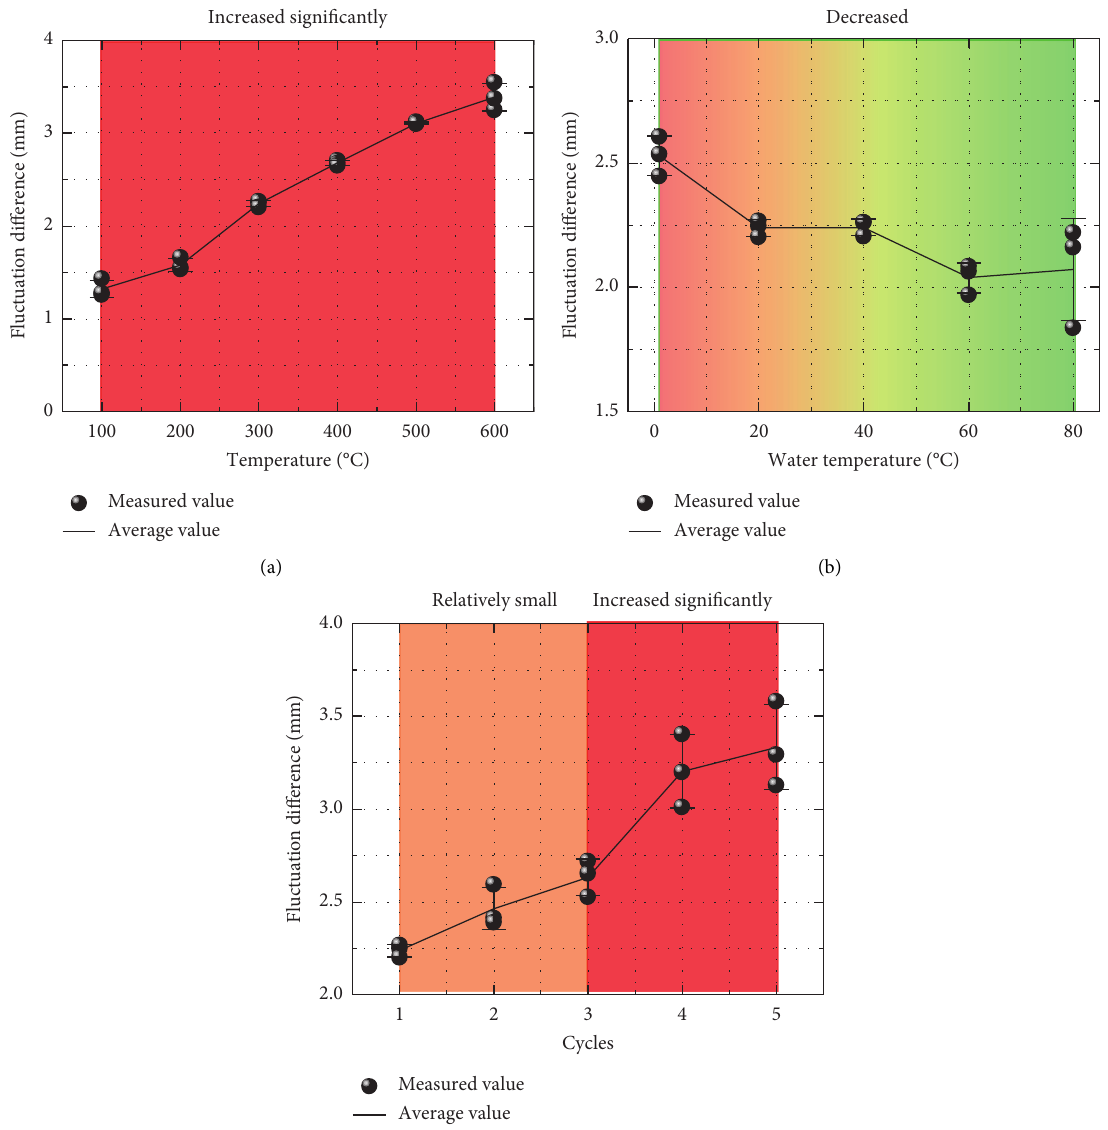
Figure 8: Height fluctuation difference in the split surfaces of specimens under different conditions of water cooling at high temperatures. (a) HDR temperature. (b) Water temperature. (c) The number of heating-cooling